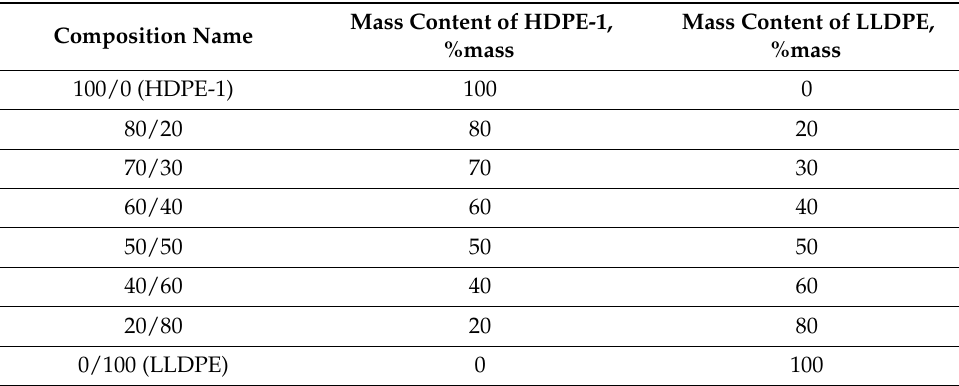
Table 2. Characteristics of the compositions based on HDPE and